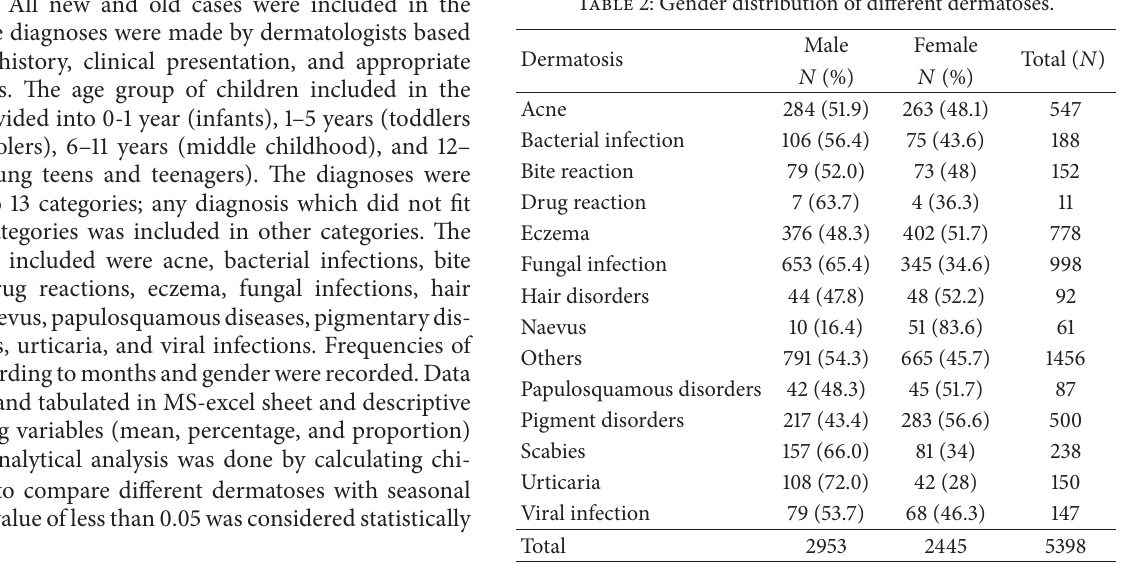
Male-female ratio was 1.2 : 1 as depicted in Table 2.